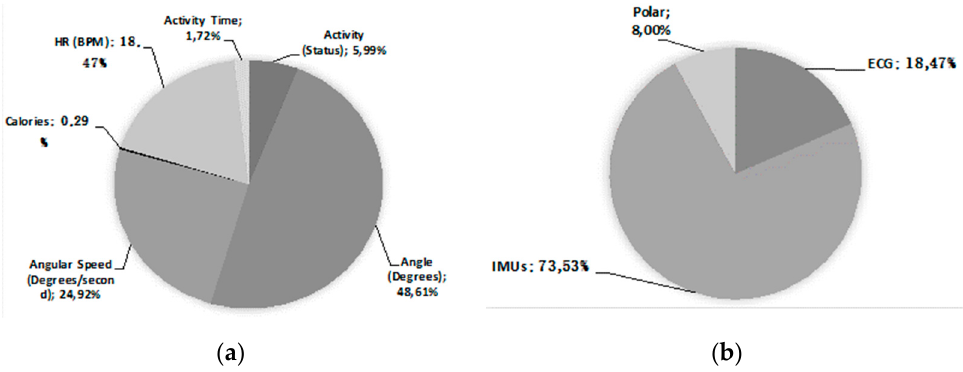
Figure 8. Distribution of the measures according to the type (left) and sensor that generated it (right).